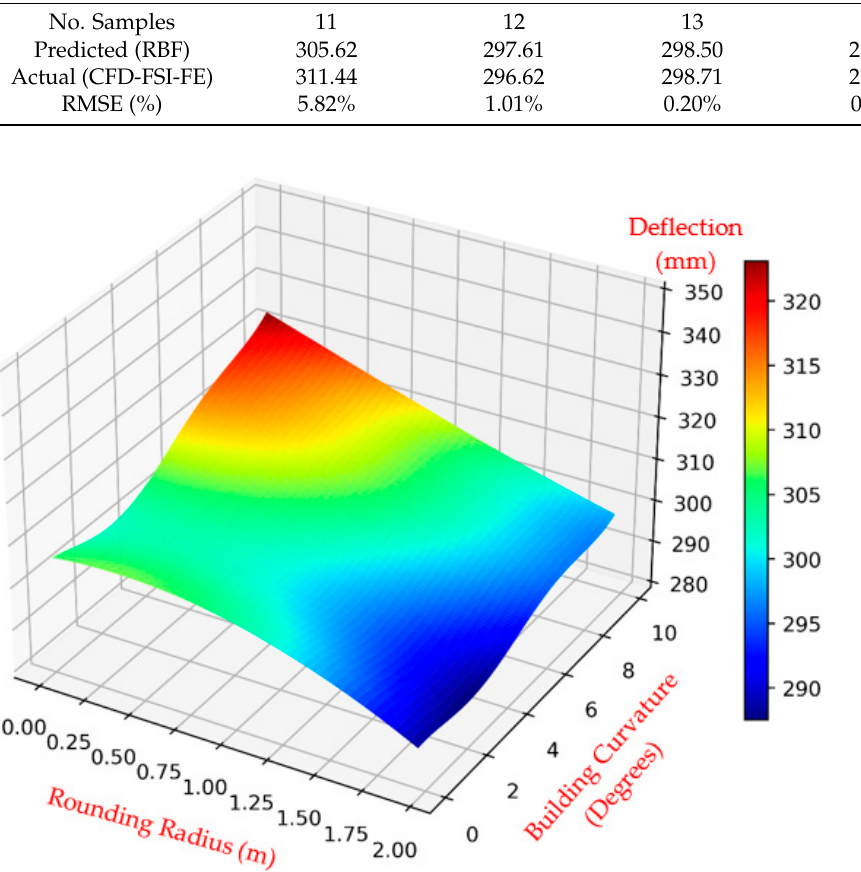
Figure 18. RBF response surface function.